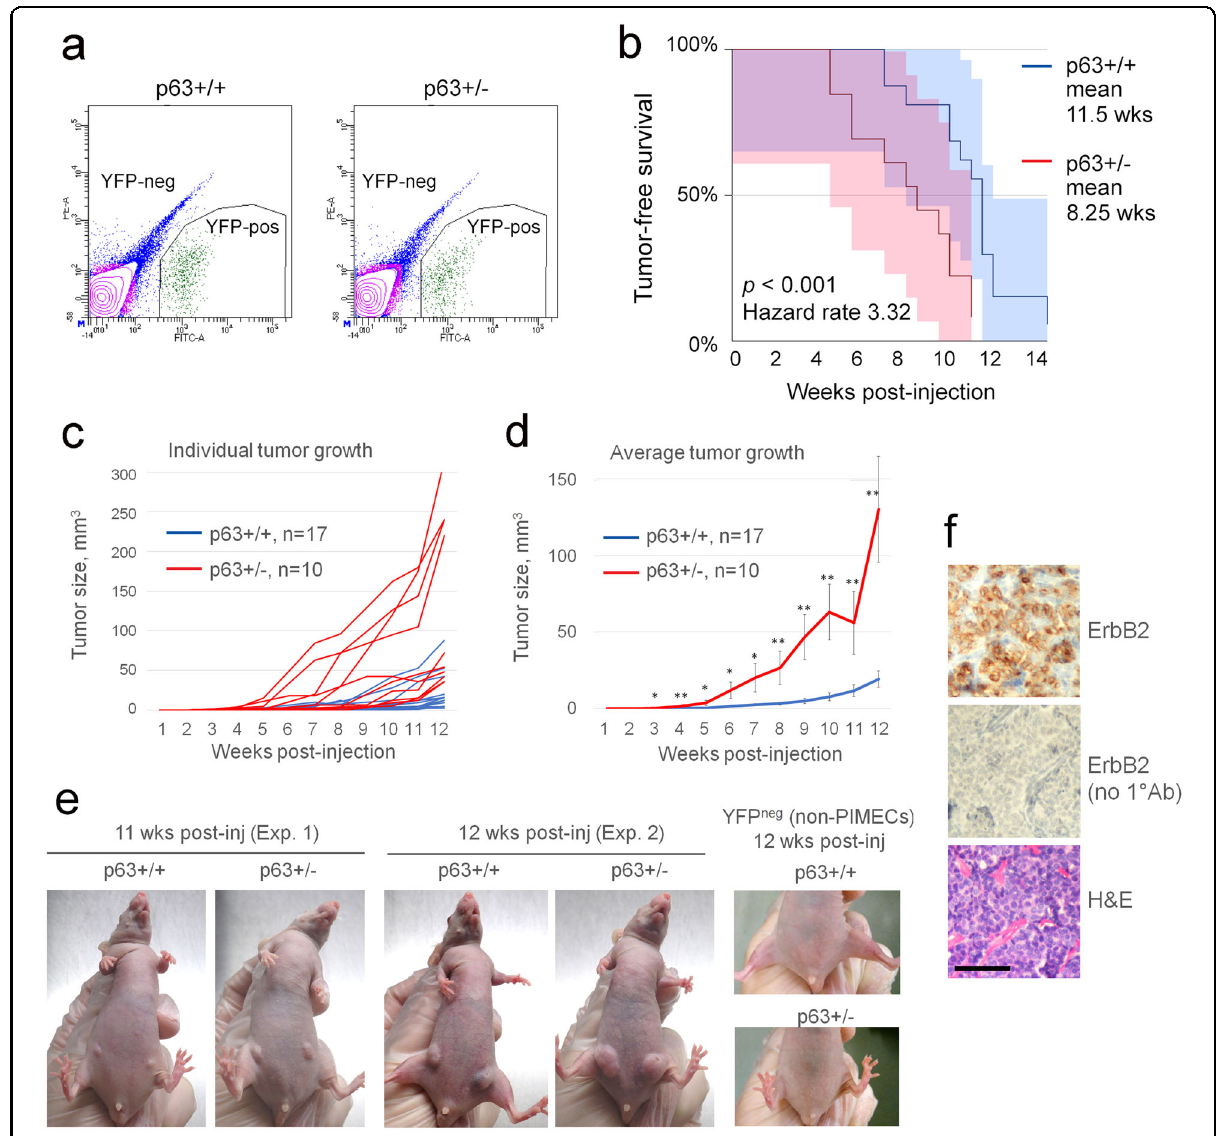
Fig. 1 Increased tumorigenicity of p63 + / − PIMECs in vivo. a Representative FACS sorting diagrams. b Tumor-free survival of the immunode fi cient recipients allografted with 5000 p63 + / + ( n = 15) or p63 + / − ( n = 12) PIMECs, Kaplan – Meier analysis, log rank statistics ( p ), shaded area is 95% con fi dence interval. c Growth of individual allografts. Note, PIMECs were obtained from four individual p63 + / + and three individual p63 + / − donors and used for n = 17 and n = 10 allografts, respectively. d Average allograft growth, mean ± SEM, * p < 0.05, ** p < 0.01. e Representative imag e s from two independent experiments. f PIMECs-derived tumors maintain their HER2 positivity until the endpoint, immunohistochemistry; scale bar, 100